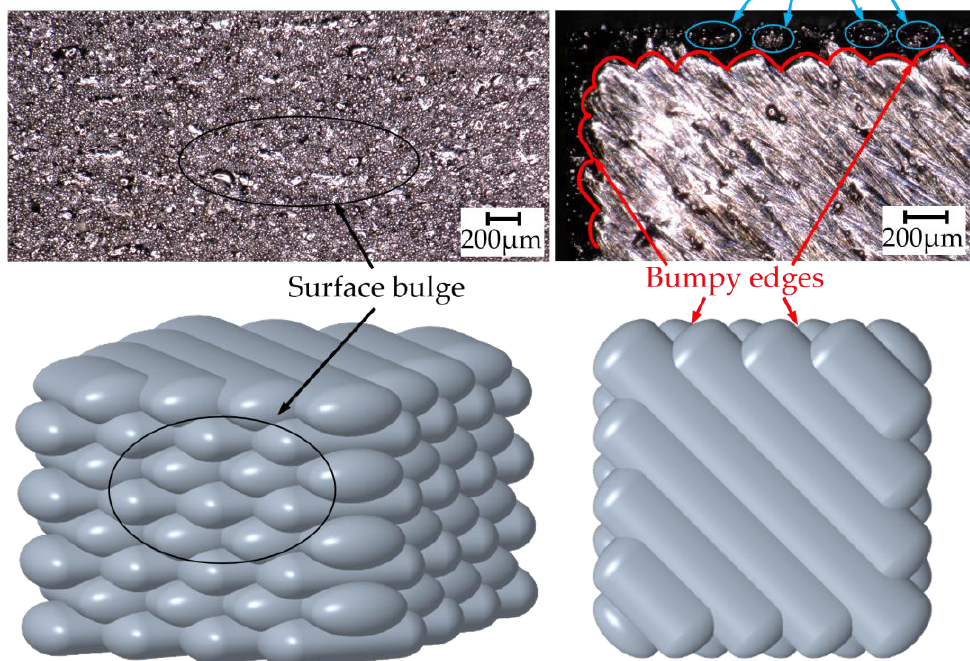
Figure 7. Schematic diagram of vertical side surface topography.